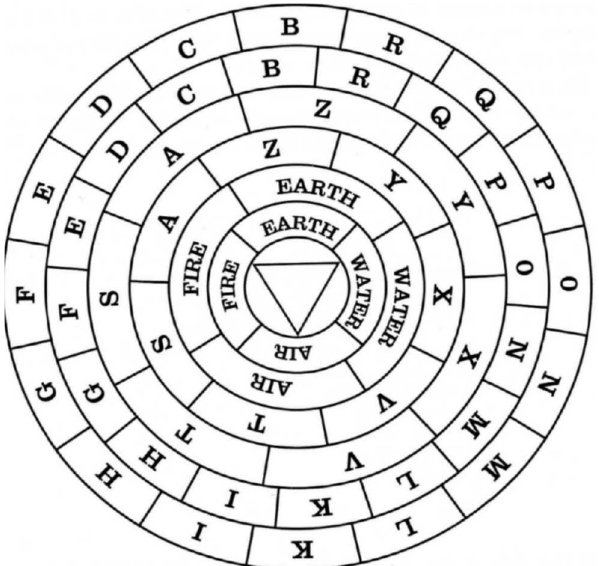
Figure 6. The demonstrative figure in the Ars Demonstrativa 7 Courtesy of Koninklijke Brill NV, Leiden The